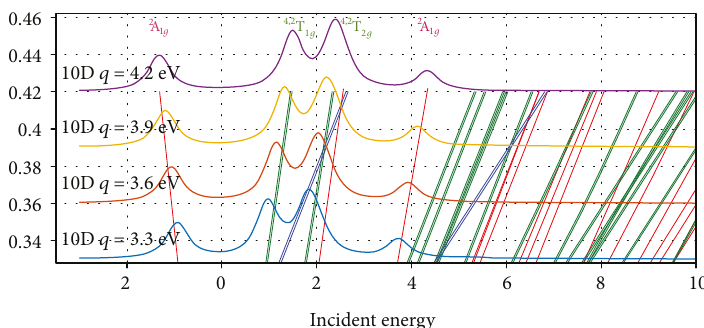
Figure 41: Low spin 1s XAS projections ( 10D q = 3 3 eV to 4 2 eV ) for Fe 3+ ( 3d 5 ) with ELD. In the single electron picture the 3d shell has either t 6 for 2 A or t 5 for 4 T and 4 T , respectively. e 0 e 1 1 g 1 g 2 g 2 g 2 g g g